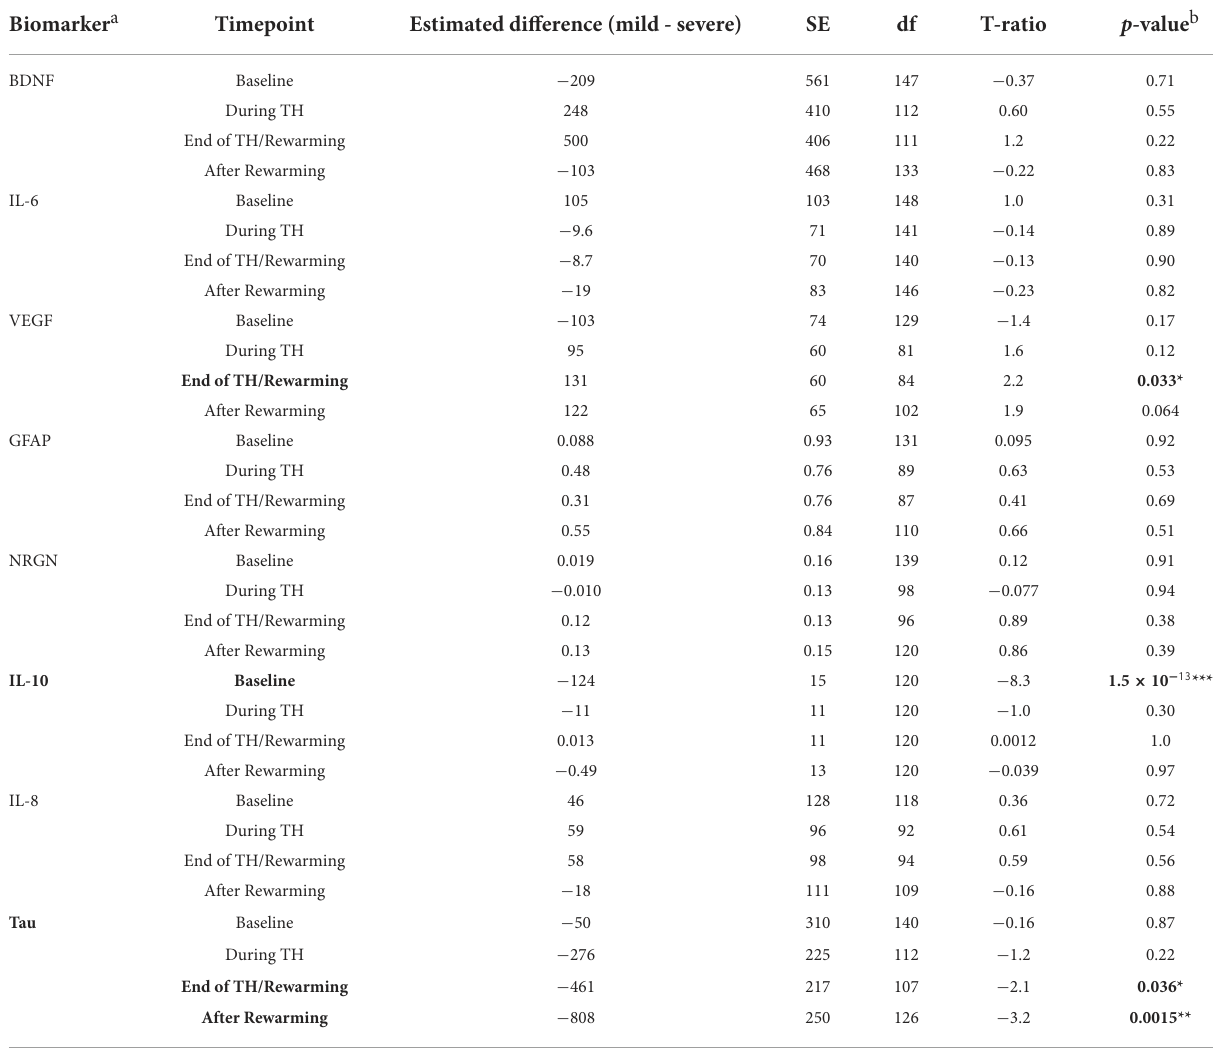
TABLE 8 Results of Welch’s t -test for the difference in biomarker values between the mild and severe groups defined by the cDTI score for each time point. Biomarker